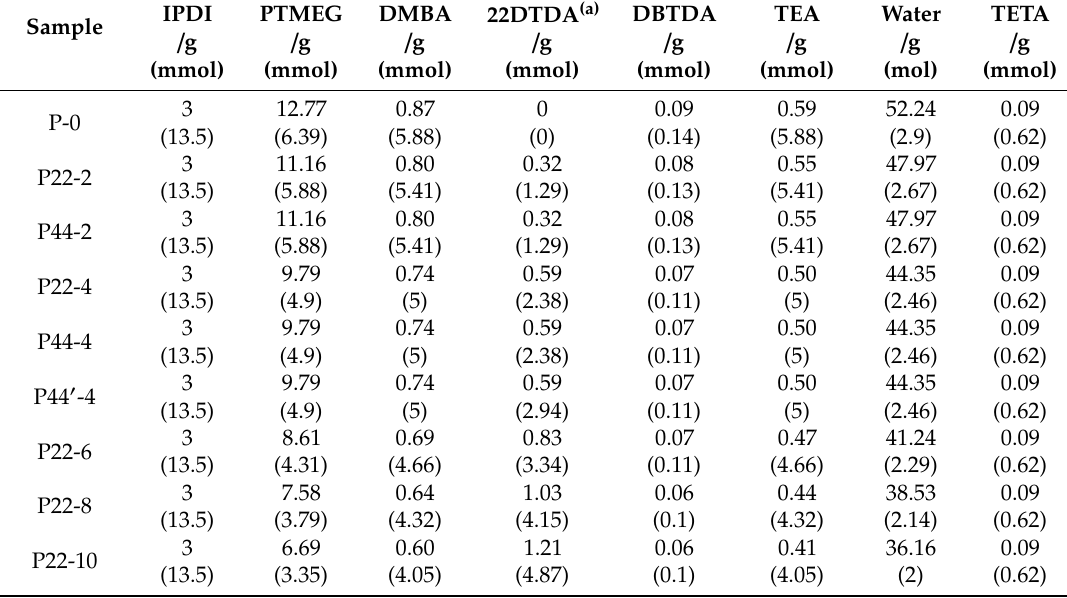
Table 1. Formulations of WPUR